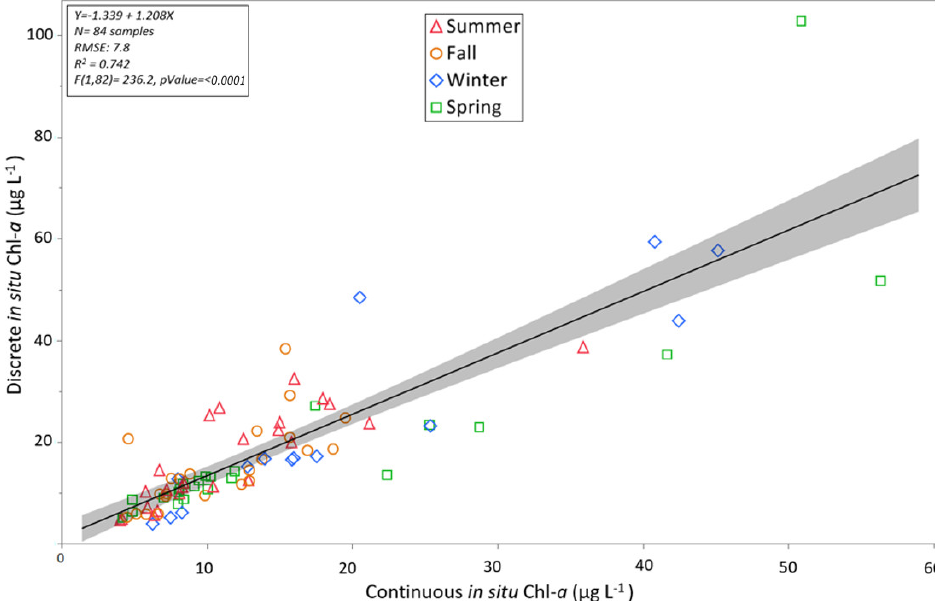
Figure 4. Linear regression parameters and coefficient of determination (R 2 ) between continuous in situ Chl- a data and [Chl- a ] extracts using 84 discrete samples collected throughout the Barataria Basin complex in the period of 2019–2020. The solid line is the best linear fit; the grey band along the regression line shows the 95% confidence interval. Summer: 9 July 2019; fall: 13 September 2019;